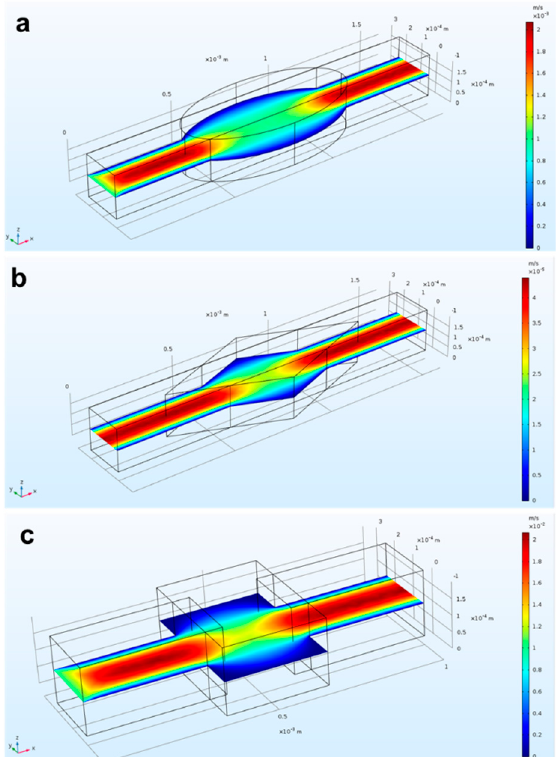
Figure 3. Simulated flow behavior into three different reservoirs: ( a ) rectangle; ( b ) rhombus; ( c ) oval. The lowest flow velocity occurred at the edges of ( a , b ).